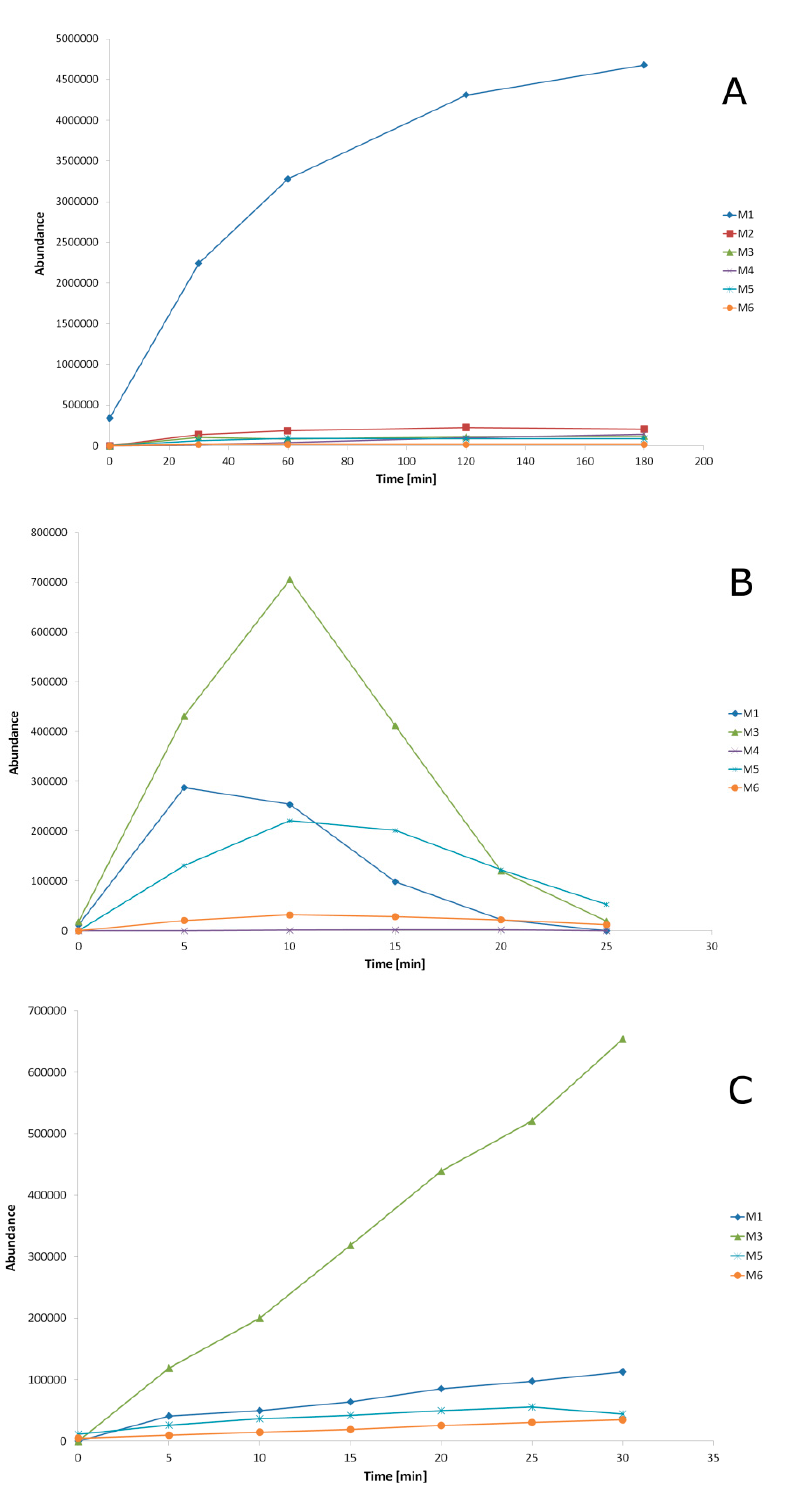
Figure 3. Total ion chromatogram obtained for HLM experiment.